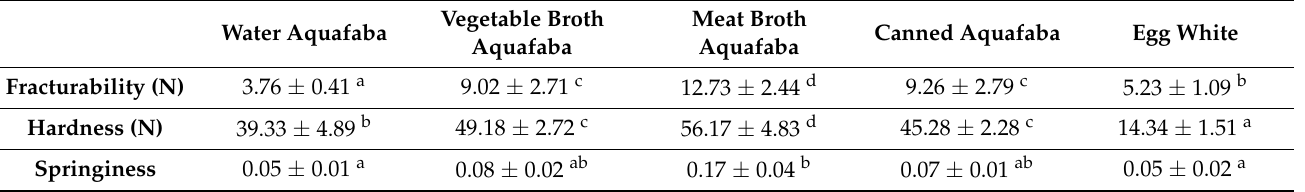
Table 2. Mean values and standard deviation obtained in the texture profile analysis of meringues made with four types of Pedrosillano chickpea aquafaba and egg